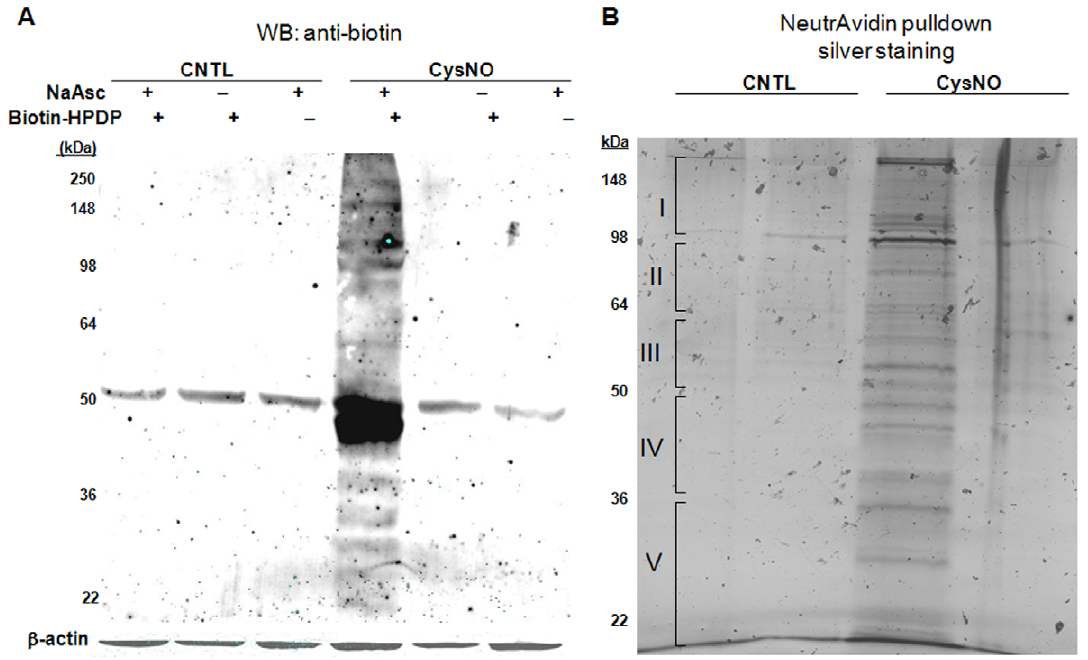
Figure 1. S- nitrosylation in NPrEC. A ) Normal prostate cells, NPrEC, were treated with or without 1 mM CysNO followed by a biotin BST. Protein extract (100 m g) was loaded onto an SDS - PAGE (10%). Western-blot analysis was carried out, and the membrane was probed with anti-biotin. B ) After cell treatment (1 mM CysNO) and the biotin switch assay, neutravidin pull-down and SD S- PAGE (4–15%) was performed (3 mg was used for IP in each lane). Each lane (CNTL, CNTL D NaAsc, CysNO, CysNO D NaAsc) was divided into five portions (I–V) as indicated and subjected to tryptic digestion and mass spectrometry protein identification.